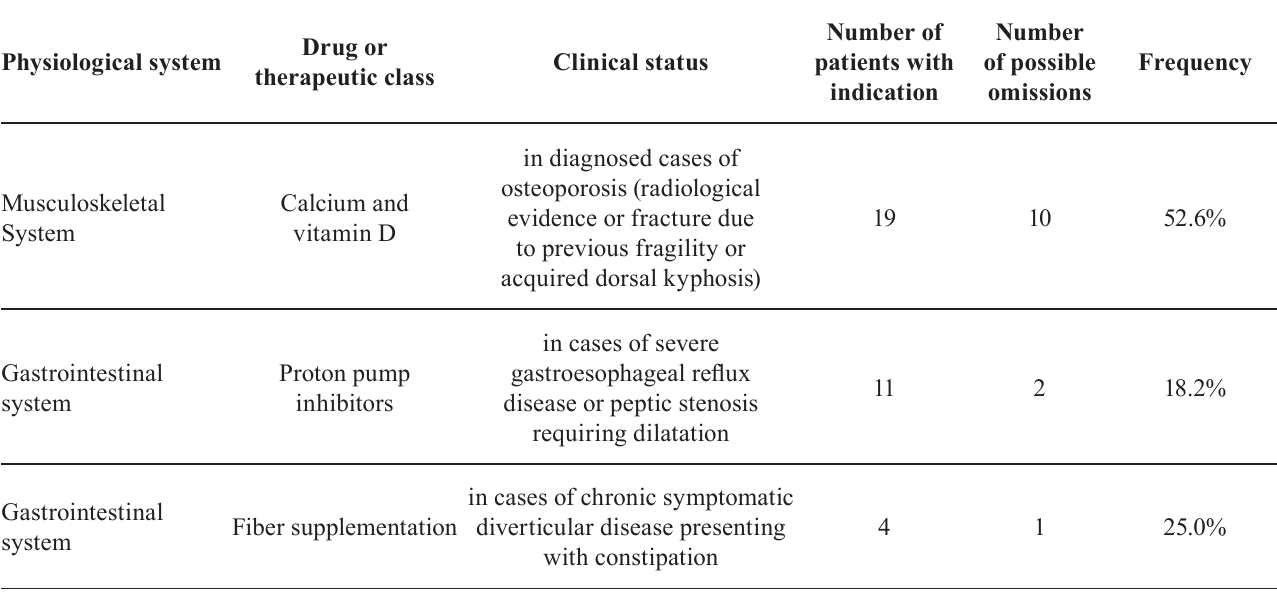
TABLE III – Main drugs or therapeutic classes that presented possible prescribing omissions at hospital discharge, according to the START criteria, validated for the Brazilian reality